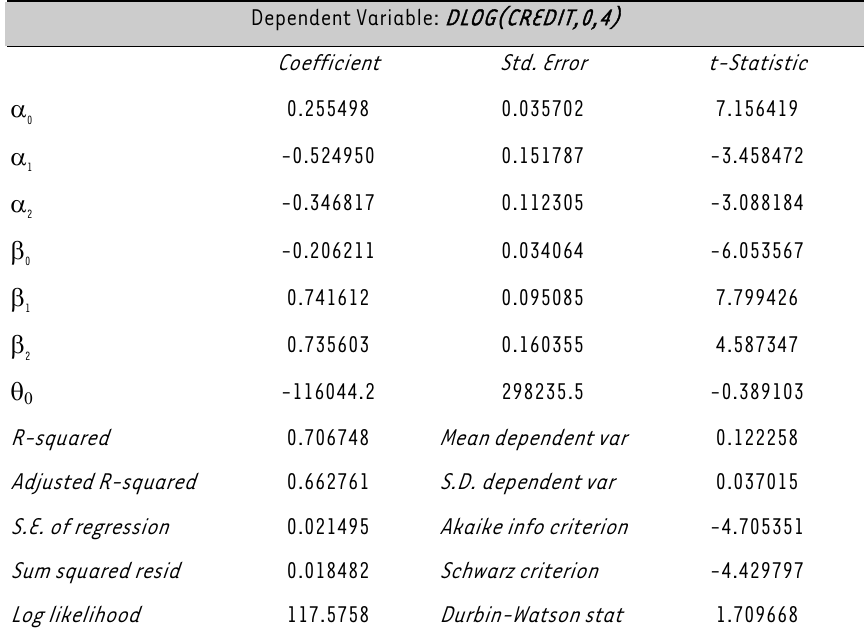
TABLE 5: Results of the ESTAR model for CREDIT Dependent Variable: DLOG(CREDIT,0,4) Coefficient Std.